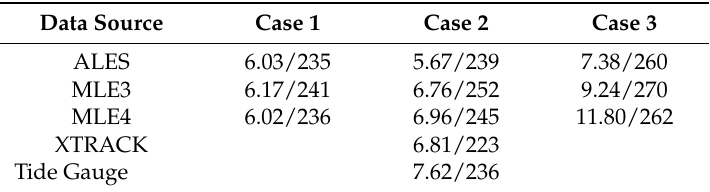
Table 5. Estimated semiannual amplitude (cm) and phase (degree) as a function of sea level data source and